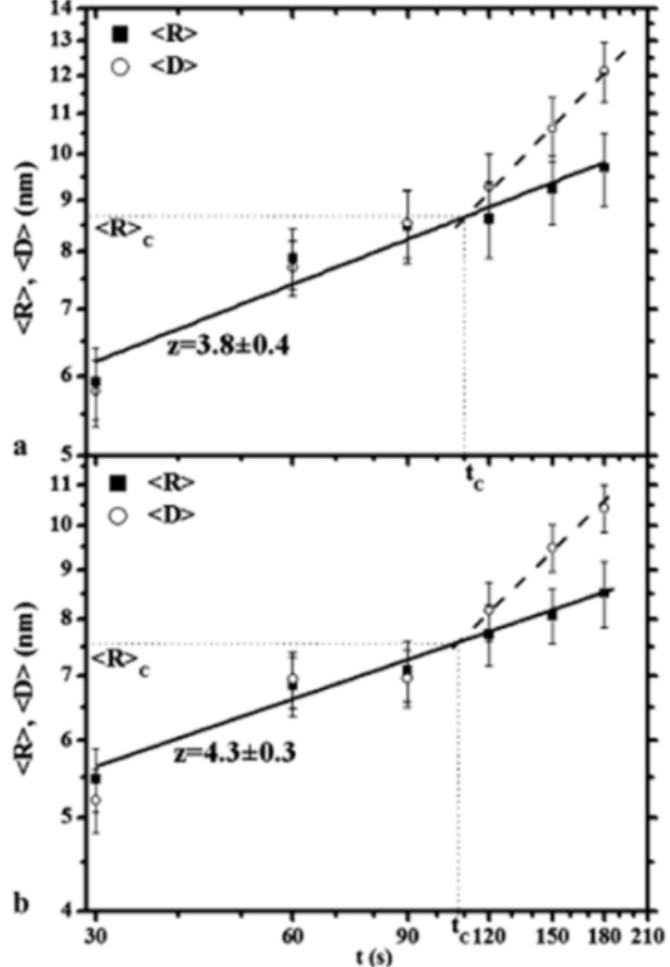
Figure 5. Evolution of the mean Au island width < R > (squares) and length < D > (circles) as a function of the deposition time (at a rate of about 0.06 nm/s) for 30 s ≤ t ≤ 180 s, on polystyrene ( a ) and on poly(methyl methacrylate) ( b ). (Reproduced with permission from [21], Copyright Springer